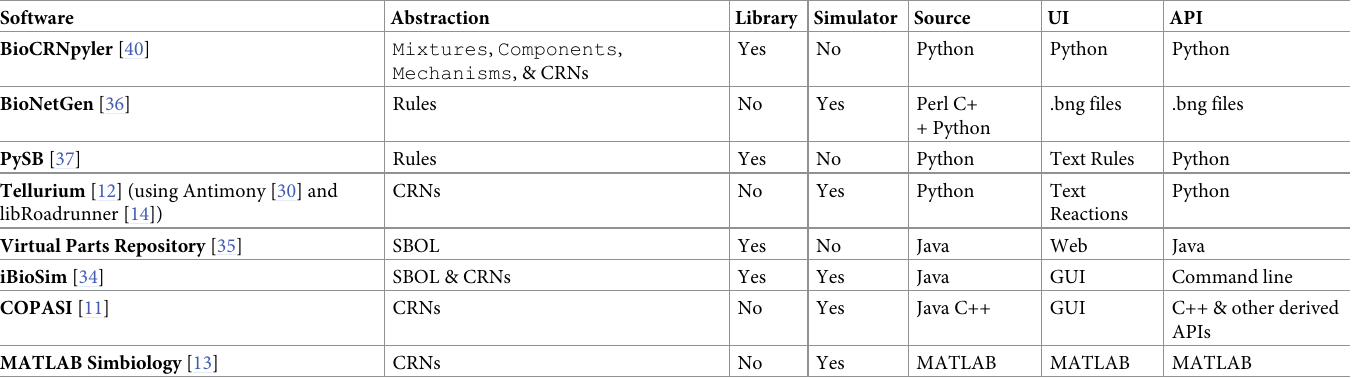
Table 1. Comparison of different simulation software. Abstraction : how models can be represented in the software. Library : whether there is a substantial library of pre-existing parts/components/sub-models that can be reused. Simulator : whether the software simulates models numerically. Source : the language(s) the software is writ- ten in. UI : the primary way a user interacts with the software. API : the primary programming language the software is designed to be accessed with.